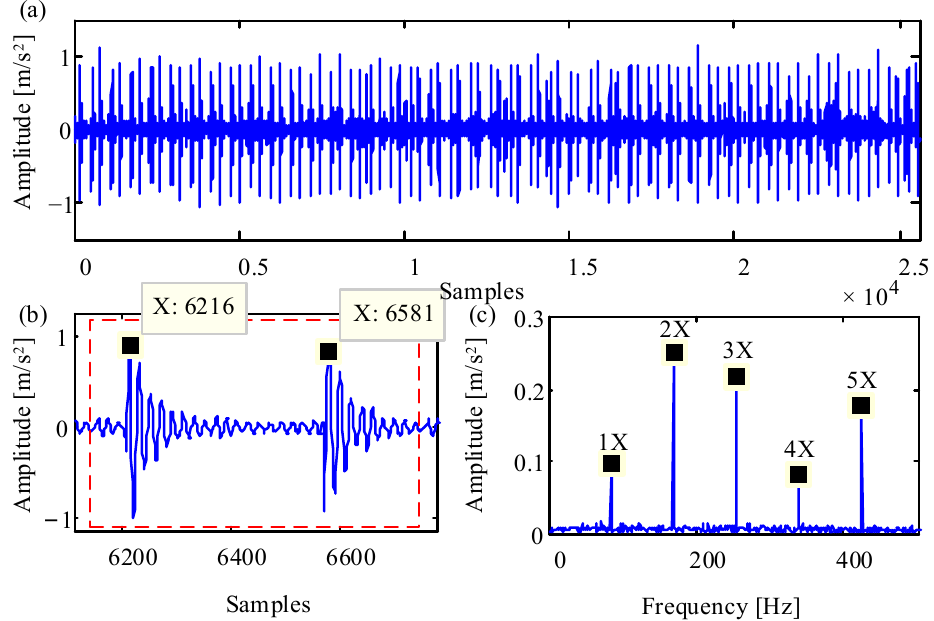
Figure 6. The results of simulated analysis at 500 rpm: ( a ) raw signal; ( b ) the local signal of ( a ); ( c ) envelope spectrum.